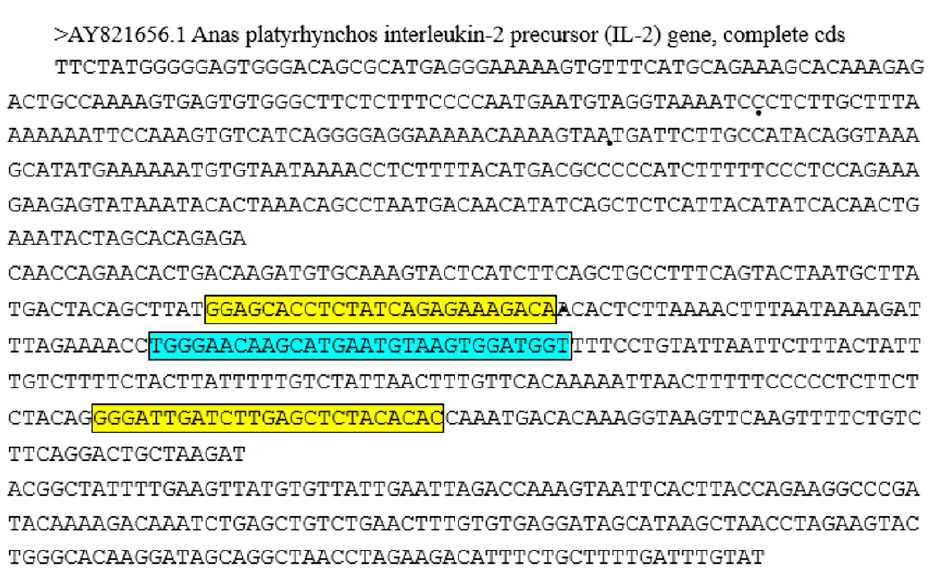
Figure 1. IL-2 gene sequence and primer-probe design location (Note: the yellow box area is the primer sequence and the blue box area is the probe